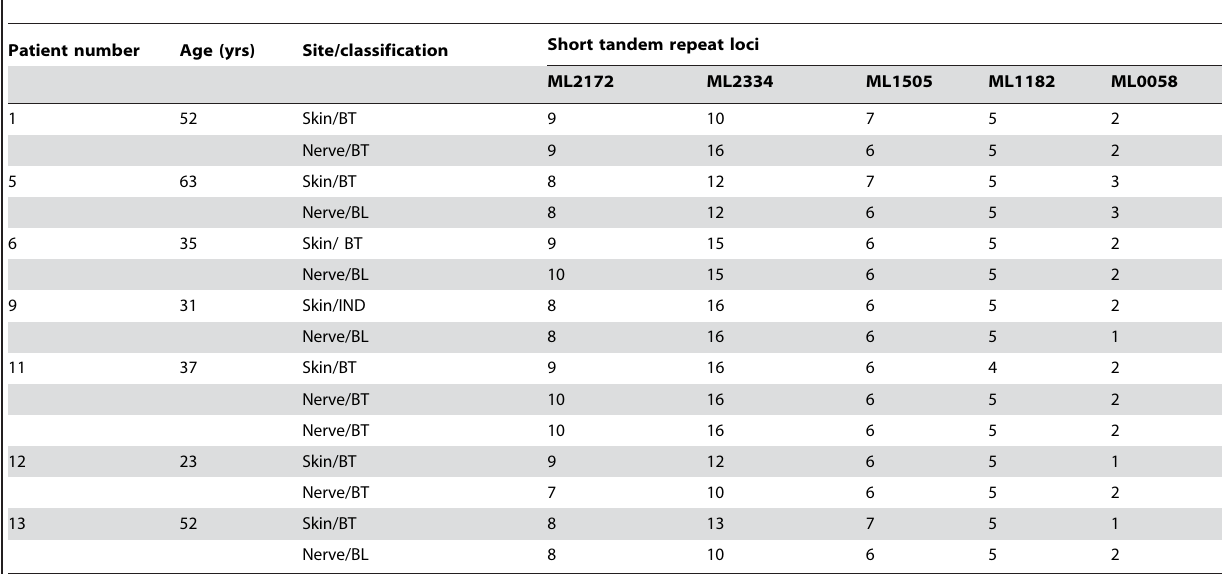
Table 4. Comparison of copy numbers of short tandem repeat loci from multiple biopsies taken at a single timepoint from different anatomical locations, from individual patients in Malawi.